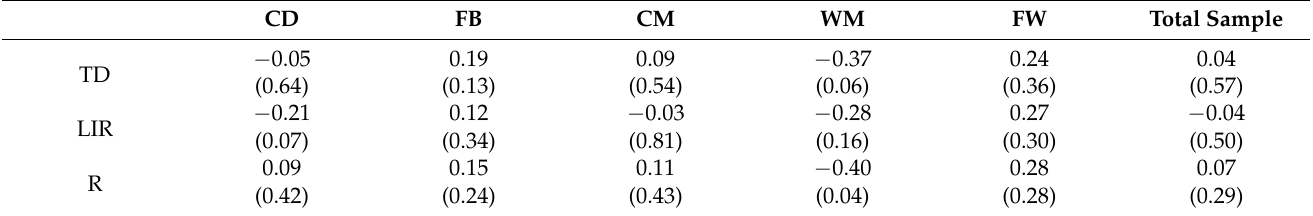
Table 2. Pearson’s correlations for players at different playing positions between running perfor- mances and total group points of theirs teams (results are given as Pearson’s coefficient ( p